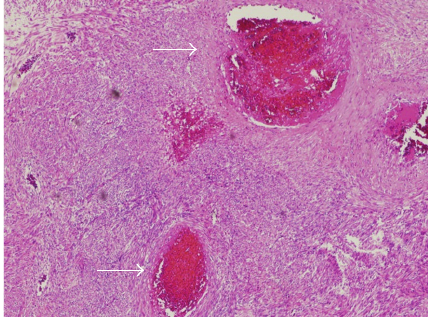
Figure 4: Microscopic view showing necrosis caused by circulatory disturbance because of multiple infarctions (arrows) in the tumor (hematoxylin-eosin stain × 40